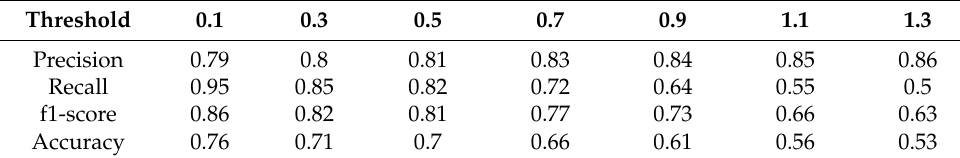
Table 3. Signal Difference using the Correlation and Their Metrics.